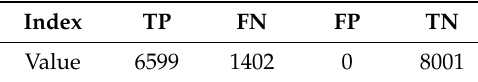
Table 2. Forecast index value.